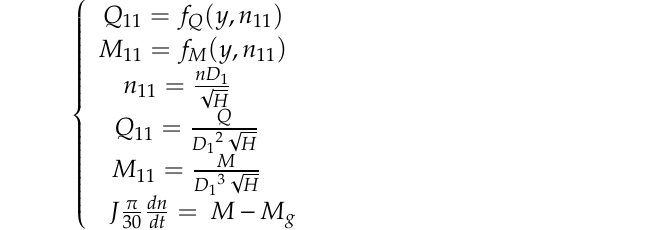
Figure 2. Di ff erence mesh for the method of characteristic. Figure 2. Difference mesh for the method of characteristic.